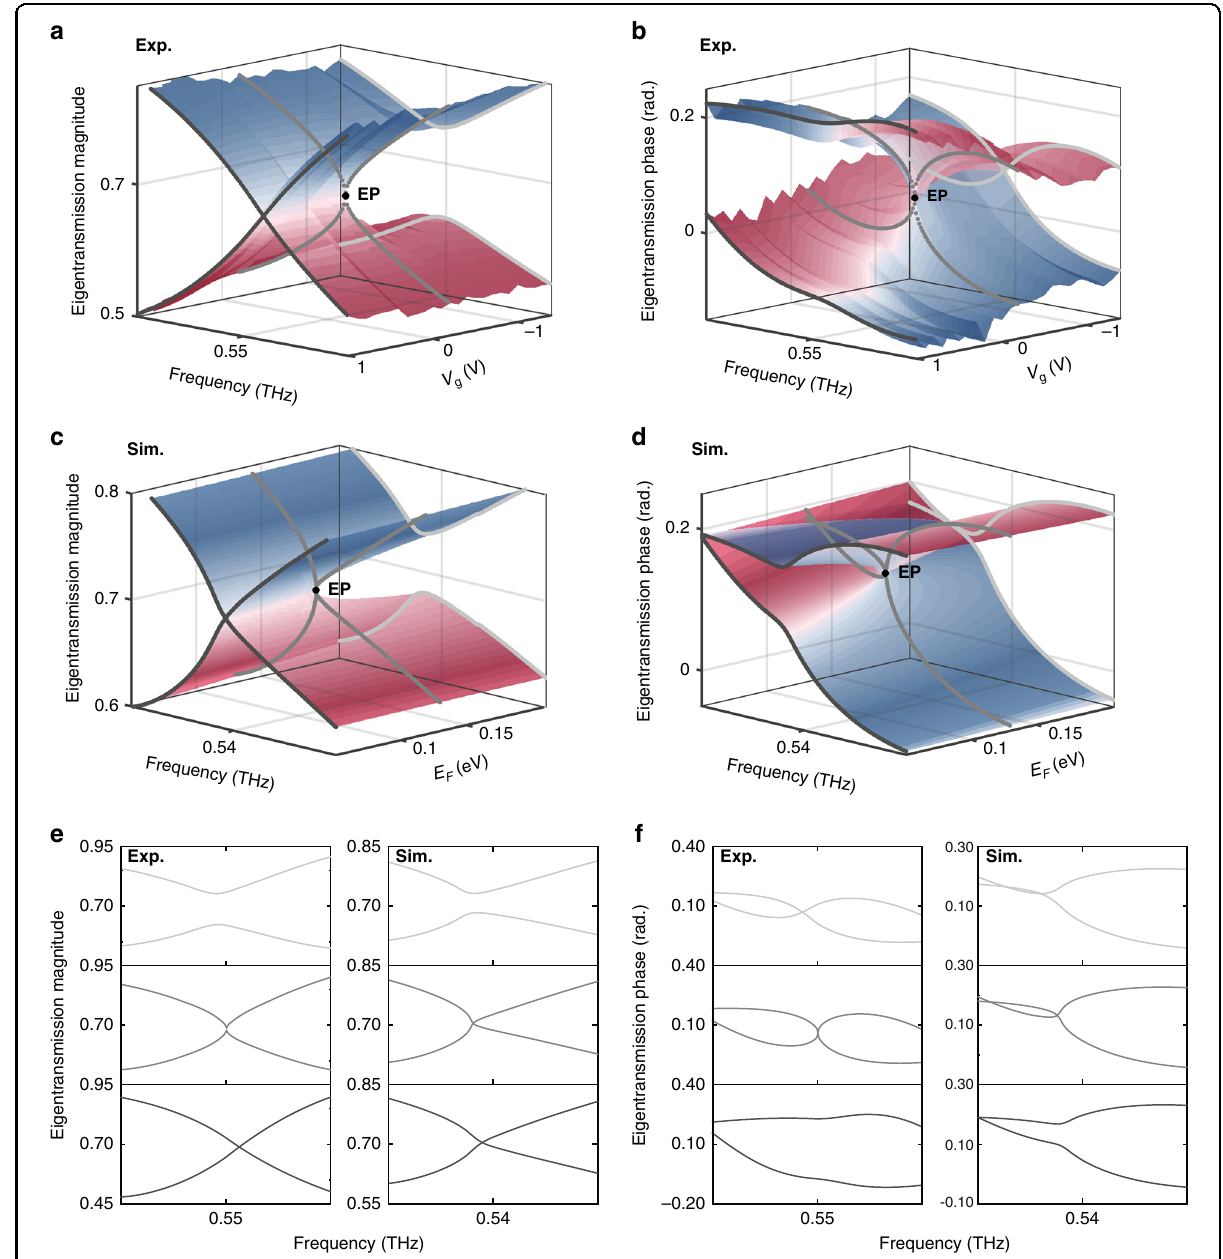
Fig. 2 Eigentransmission magnitude and phase of the non-Hermitian gated graphene metasurface. a , b Experimentally-extracted eigentransmission magnitude ( a ) and phase ( b ) plotted in the parameter space spanned by the input frequency and the gate voltage V g . The chiral EP is signi fi ed by a point (drawn with a black dot) on each of the Riemann surfaces. The chiral EP is measured to be located at the frequency of 0.55 THz and the gate voltage of V g,EP = − 0.2 V. c , d Numerically-calculated eigentransmission magnitude ( c ) and phase ( d ) plotted in the parameter space spanned by the input frequency and the Fermi level E F . The chiral EP is found to be located at the frequency of 0.54 THz and E F = 0.13 eV. e , f Sectioned plots of experimentally-extracted and numerically-simulated eigentransmission magnitude ( e ) and phase ( f ) at three values of gate voltage − 1.1 V, − 0.2 V, and 1.3